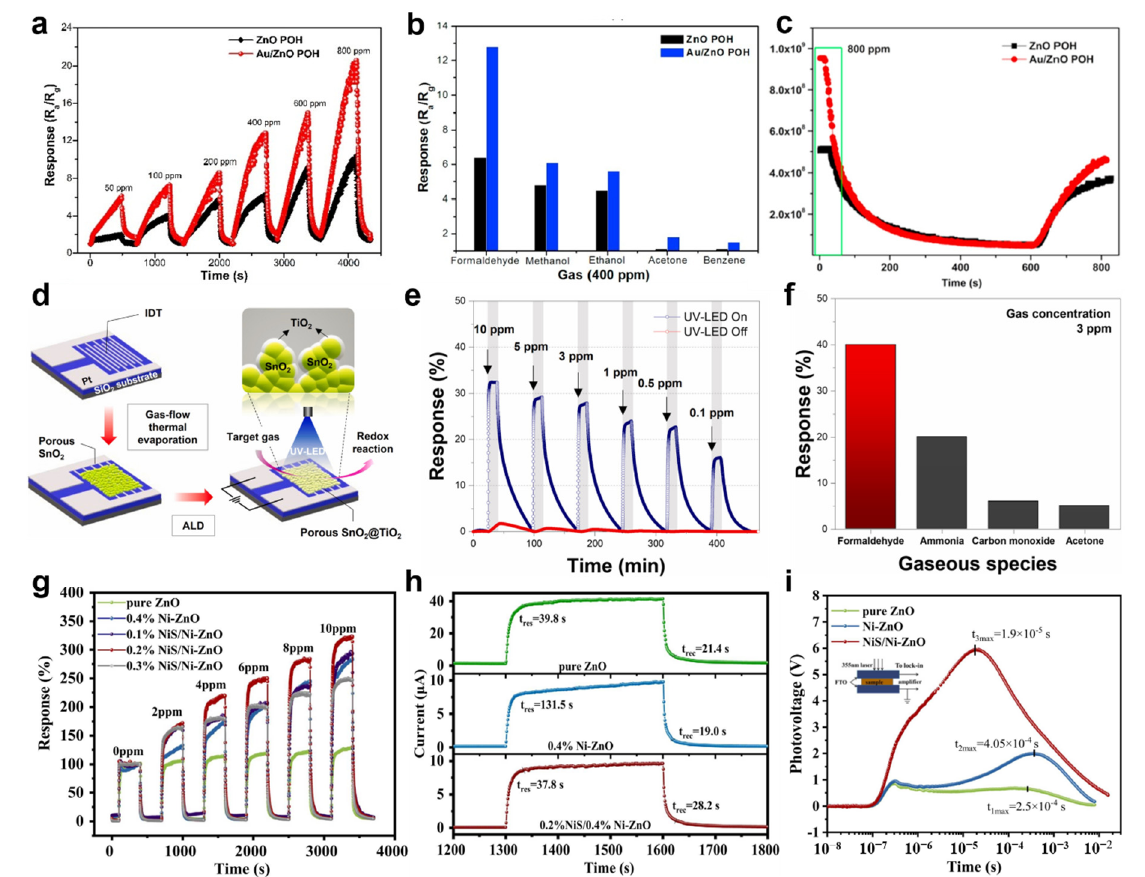
Figure 4. ( a ) Response of ZnO POH sensor and Au − ZnO POH sensor under UV irradiation; ( b ) response of the ZnO POH and Au − ZnO POH sensors to various gases; ( c ) actual resistance changes in the ZnO POH and Au − ZnO POH sensors (adapted from [90] with permission from the Elsevier B.V.); ( d ) schematic diagram of the SnO 2 @TiO 2 sensor fabrication process; ( e ) response of the SnO 2 @TiO 2 sensor in UV − on and UV − off; ( f ) selectivity characteristics of the SnO 2 @TiO 2 sensor (adapted from [91] with permission from the Elsevier B.V.); ( g ) response of the pure ZnO, Ni − ZnO, and NiS/Ni − ZnO gas sensors to UV irradiation; ( h ) response time of the pure ZnO, Ni − ZnO, and NiS/Ni − ZnO gas sensors to HCHO gas; ( i ) spectrum of transient photovoltage (TPV) (adapted from [92] with permission from the Elsevier B.V.).